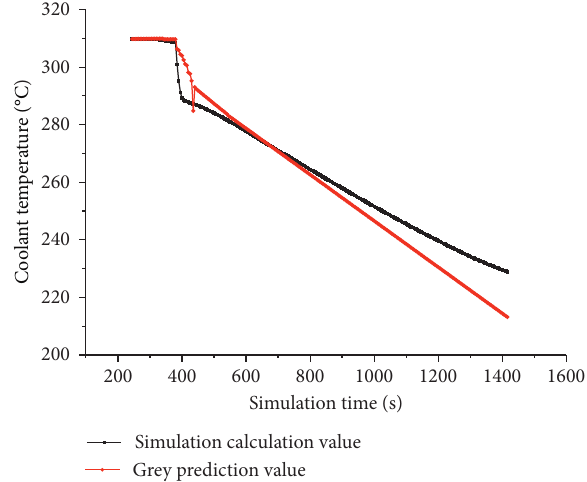
Figure 11: The comparison of the actual and predicted coolant temperature